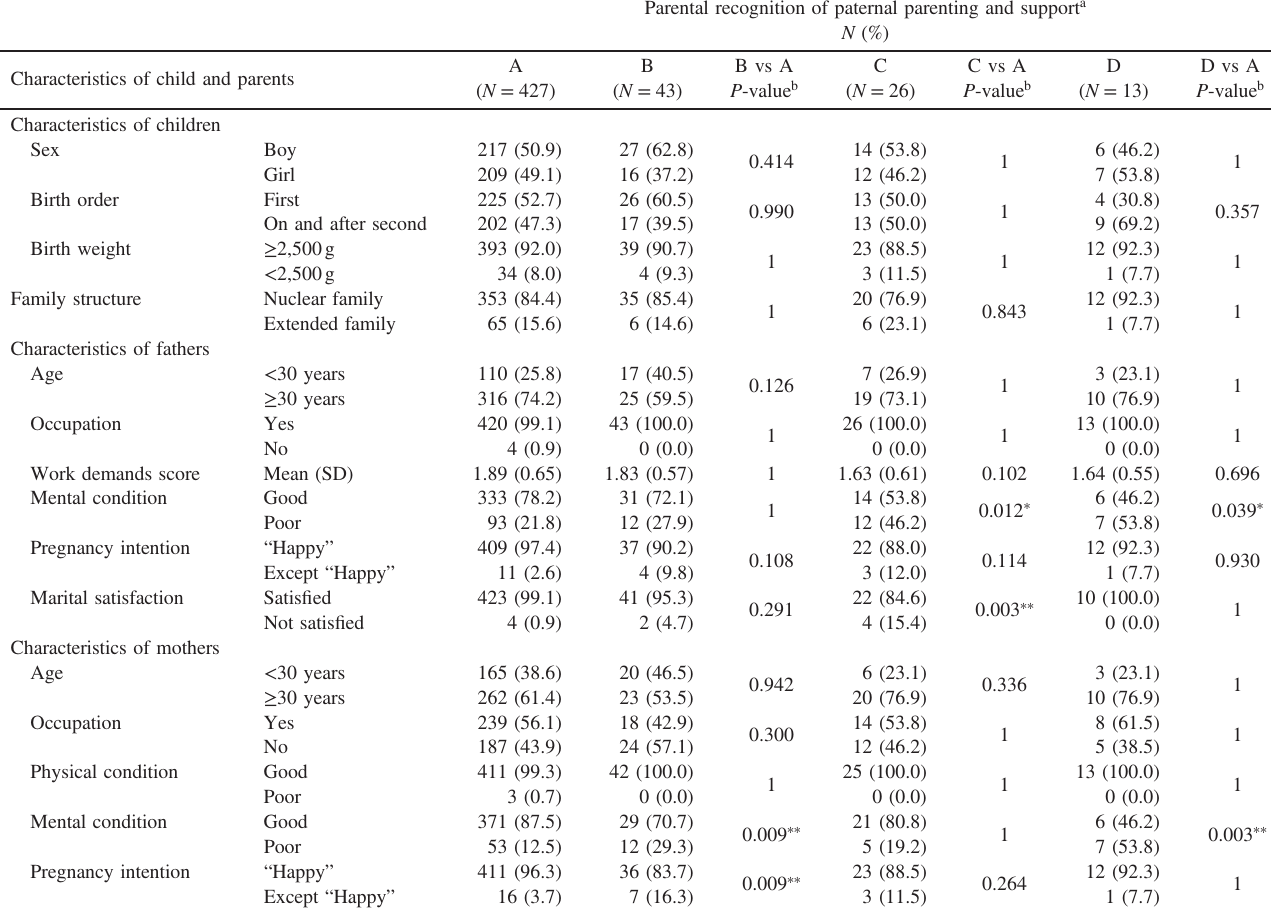
Parental recognition of paternal parenting and support a